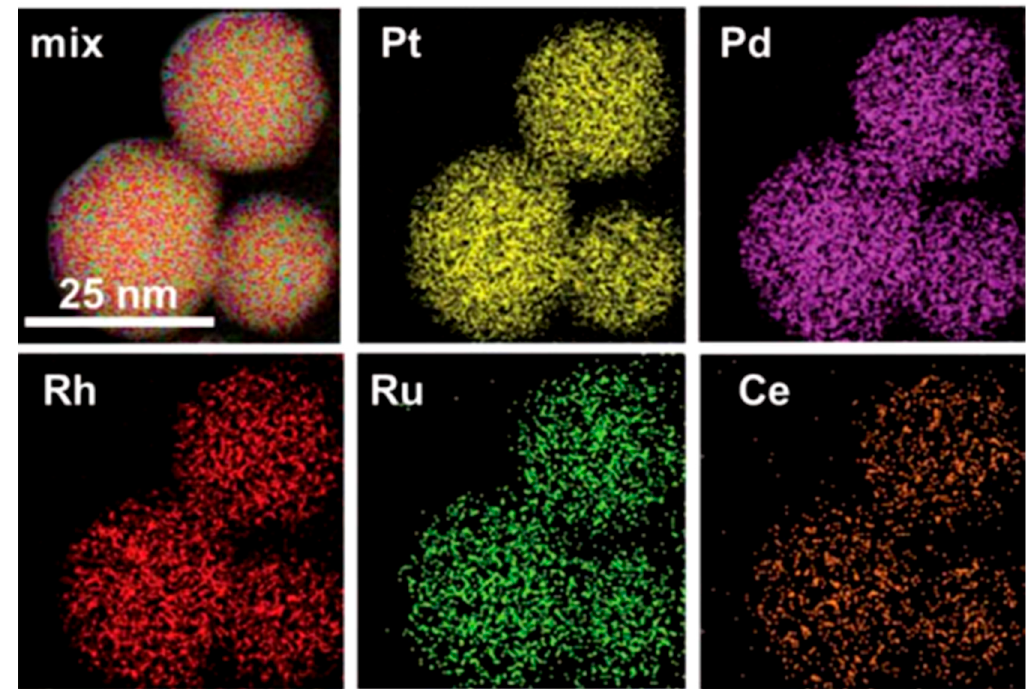
Figure 6. Scanning transmission electron microscope (STEM) elemental maps for PtPdRhRuCe high-entropy-alloy nanoparticles (HEA-NPs), reproduced from [46], with permission from authors.